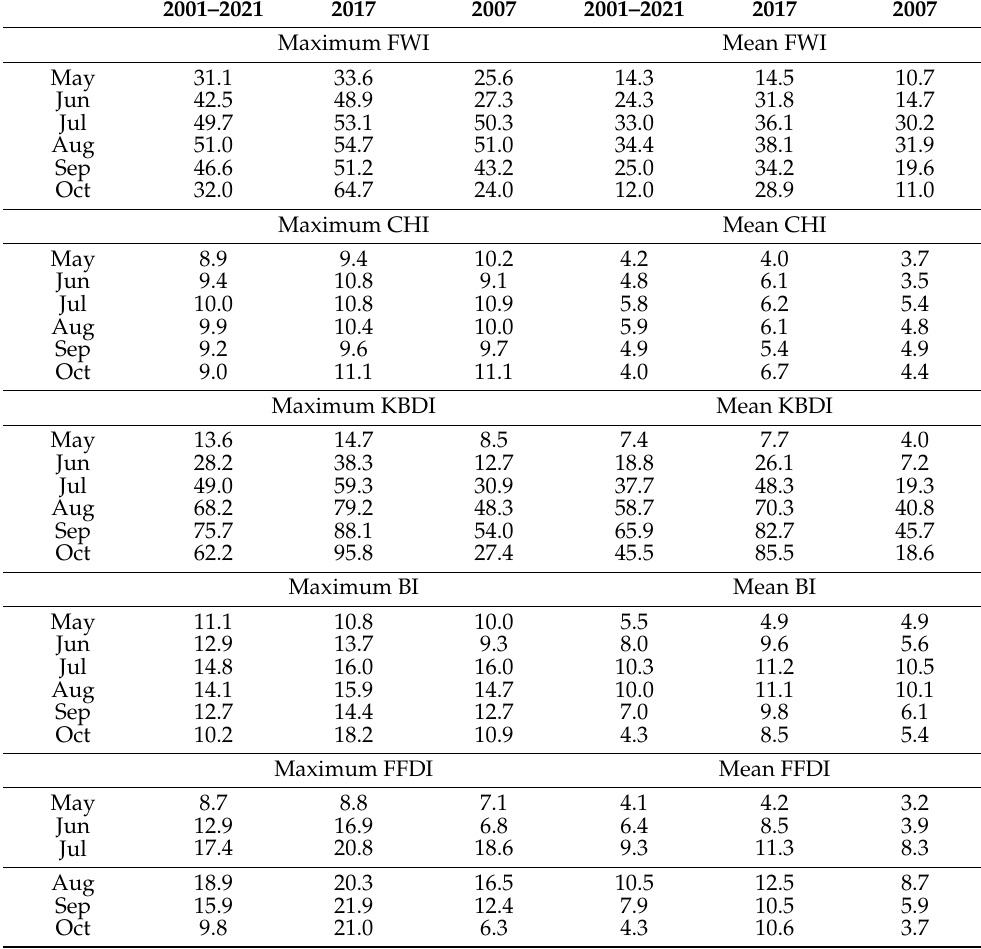
Table 6. Maximum and mean monthly average values for 2001–2021 (baseline climate), 2017, and 2007 for FWI, CHI, KBDI, BI, and FFDI, respectively for mainland